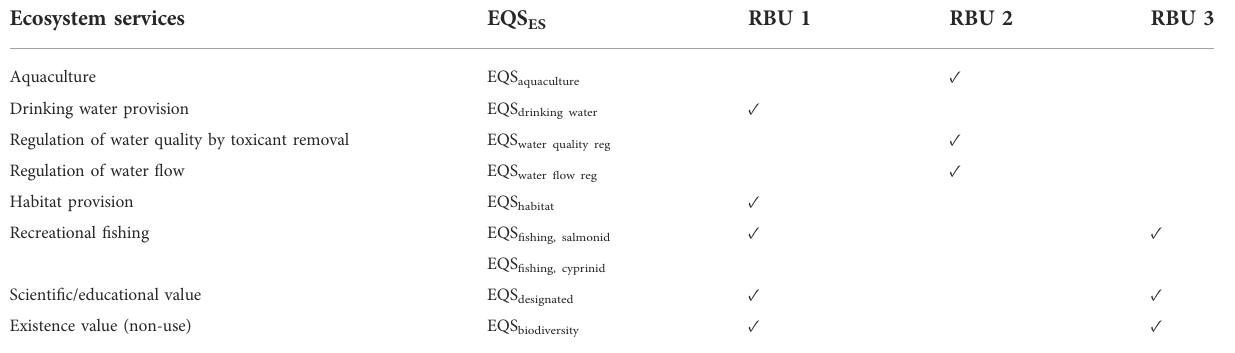
TABLE 4 Ecosystem service bundles for three hypothetical river basin units